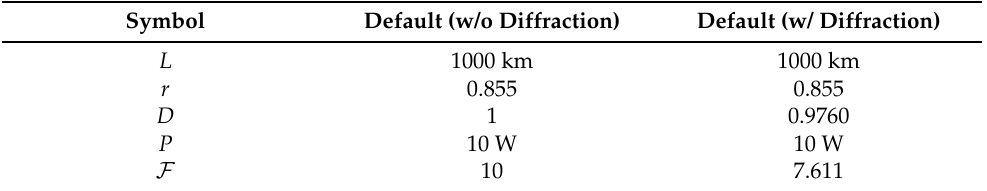
Table 1. Mechanical and optical default parameters of DECIGO. L is the cavity length, r is the reflectivity of the mirror, D is the coefficient of the diffraction, P is the laser power, and F is the finesse of the FP cavity. The finesse is calculated in the two cases: with and without the diffraction loss. Symbol Default (w/o Diffraction) Default (w/ Diffraction) L 1000 km 1000 km r 0.855 0.855 D 1 0.9760 P 10 W 10 W F 10